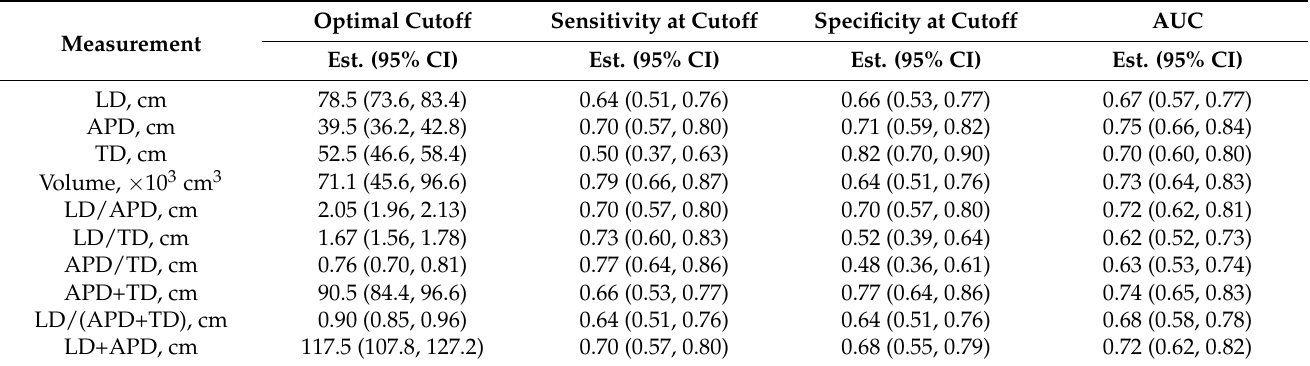
Table 3. Results of nonparametric receiver operating characteristic (ROC) analysis conducted on the absolute uterine diameters, simple and complex diameter ratios and volume of the uterus to discriminate